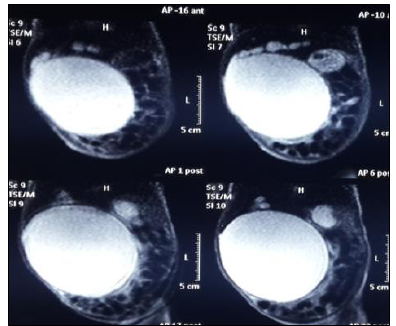
Figure 1: MRCP showing large cyst